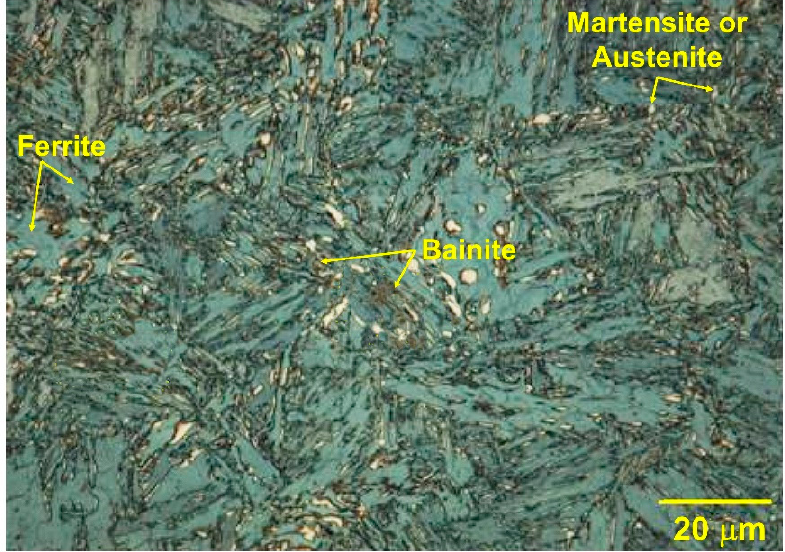
Figure 7. Optical micrography of M390-300 steel etched with sodium metabisulfite (10% in distilled water) plus picric acid (4% in ethanol).